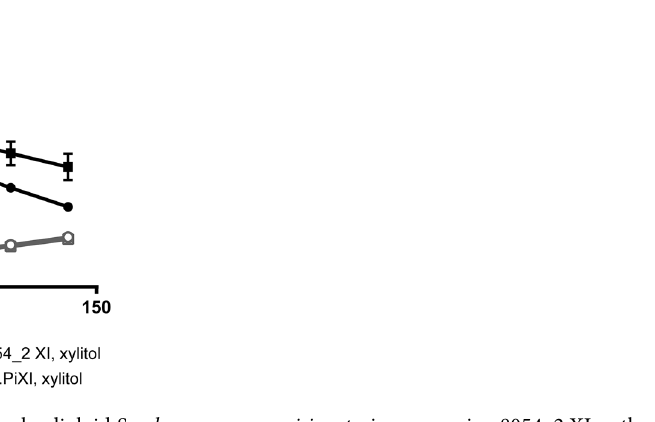
Figure 4. The d-xylose consumption by diploid Saccharomyces cerevisiae strains expressing 8054_2 XI or the codon-optimized XI from Piromyces sp. E2 (opt.PiXI). Cultures were grown under high cell density (10 g L −1 DCW) in shake flasks on synthetic medium with 4% (w/v) d-xylose as the sole carbon source. Data points represent an average of 3 biological replicates with standard deviation